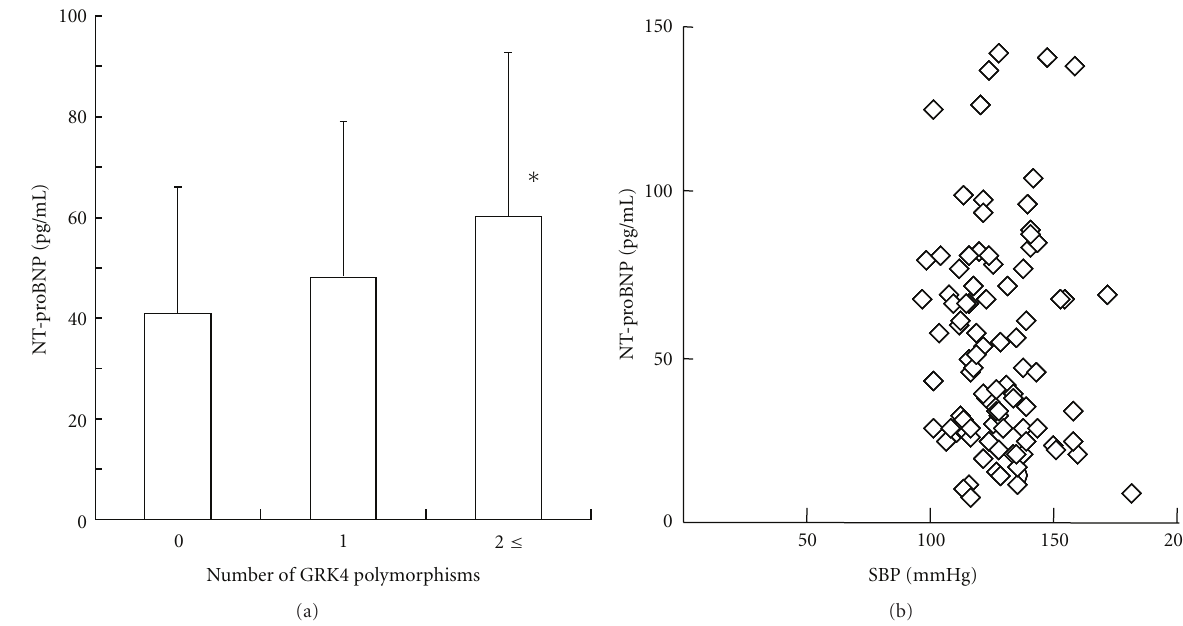
Figure 2: (a) Relationship between the number of GRK4 polymorphic alleles GRK4 (R65L, A142V, A486V—LL, VV, VV = 6 alleles) and NT-proBNP concentration. Number of subjects is indicated in each bar. Subjects with incomplete GRK4 genotyping were not included in the analysis. ∗ P < 0 . 05 versus GRK4 SNP-free subjects. (b) The relationship between systolic blood pressure (Systolic BP) and NT-proBNP